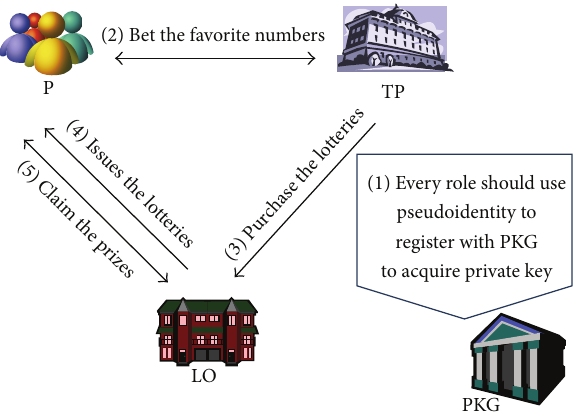
Figure 1: The structure of our scheme. 𝑔 = 𝑖 𝑑 PKG 𝑗